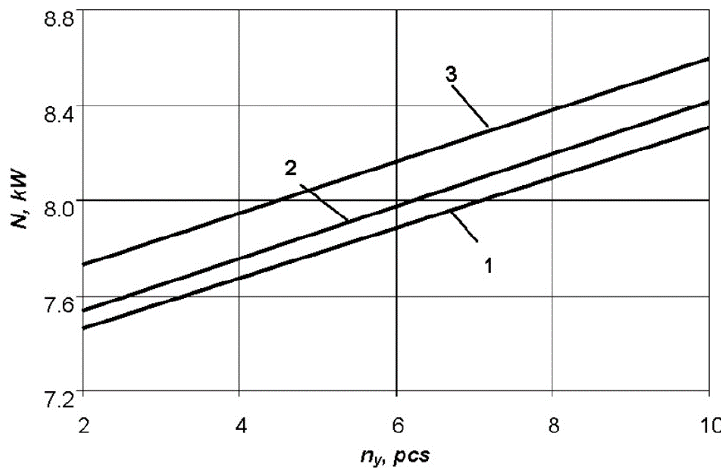
Figure 7. Graph of dependence of the power consumption on the number of stiffening ribs of various materials of the shaping surface of the tool: 1—fiberglass; 2—aluminium alloy;